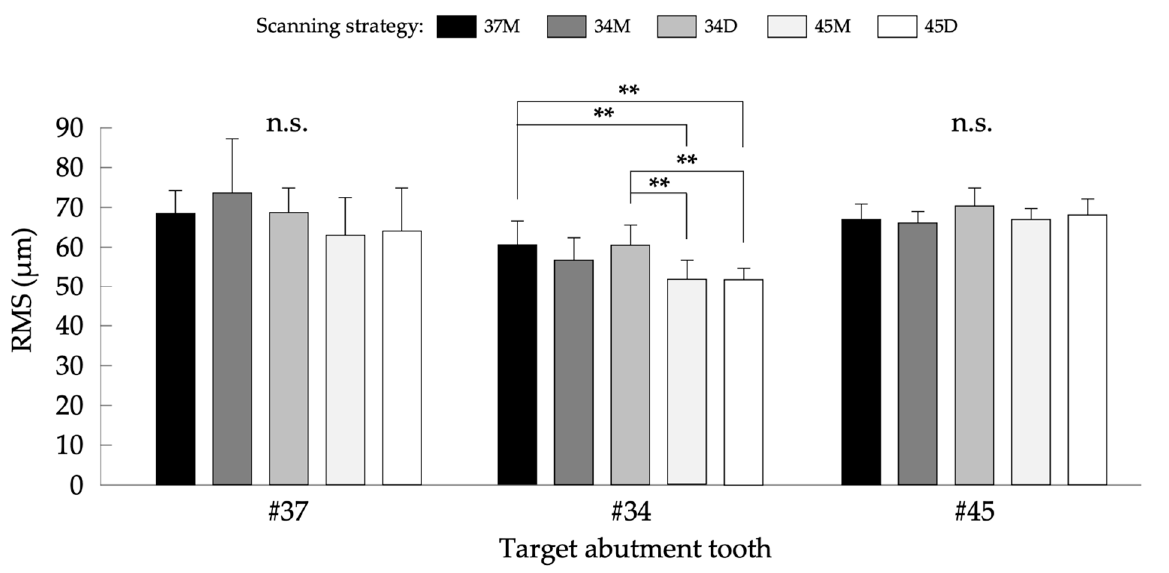
Figure 4. Results of the comparisons of T G for each target abutment tooth among five scanning strategies. n.s.: not significant; and **: p < 0.01.